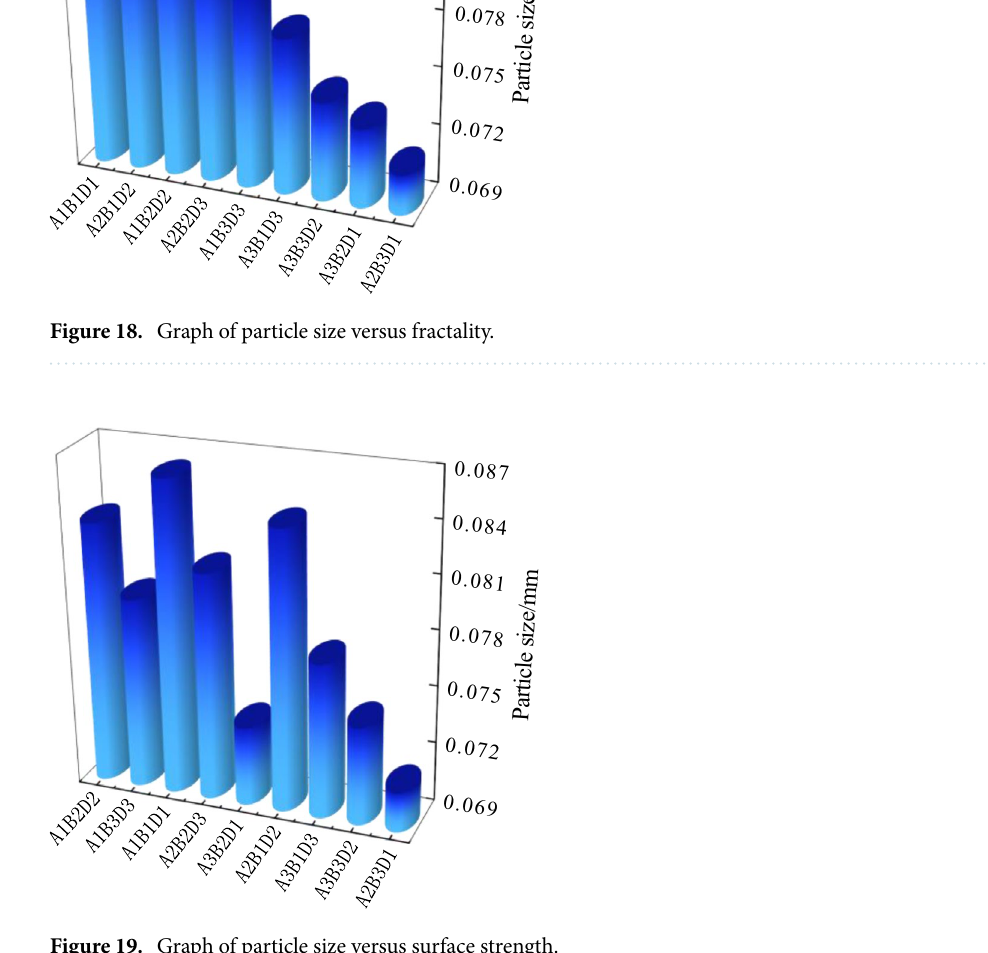
Figure 19. Graph of particle size versus surface